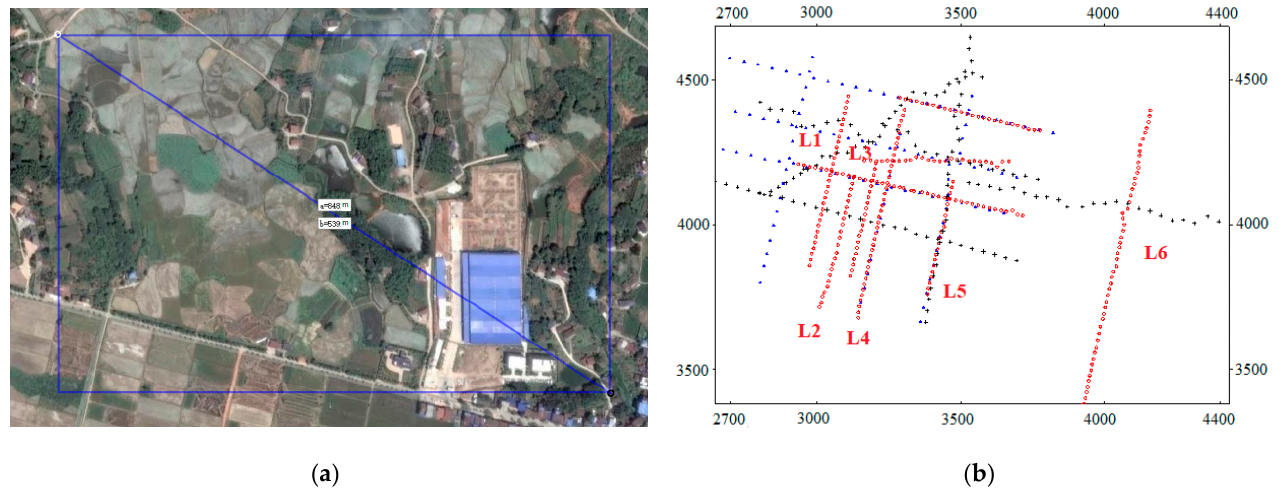
Figure 8. Geophysical prospecting arrays in the Huarong Survey Area. ( a) Pseudo-3D arrays. ( b ) The combined profiling method, resistivity sounding method, and CSAMT arrays (the black cross-shaped measuring points are the combined profiling and resistivity sounding points, and the red circles are the CSAMT measuring points. The black cross-shaped measuring points are the pseudo-3D resistivity point).